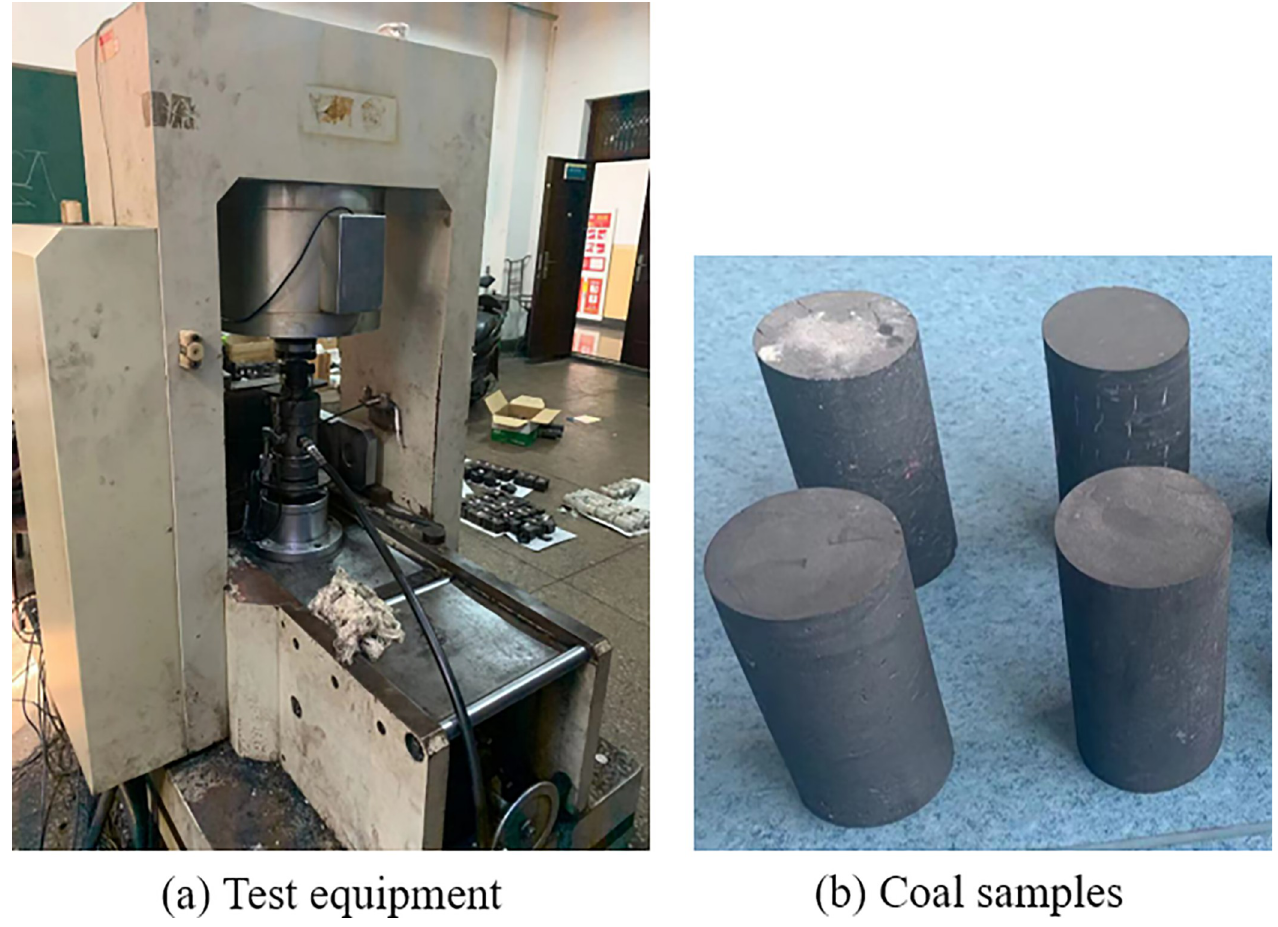
Fig 2. Test equipment and coal